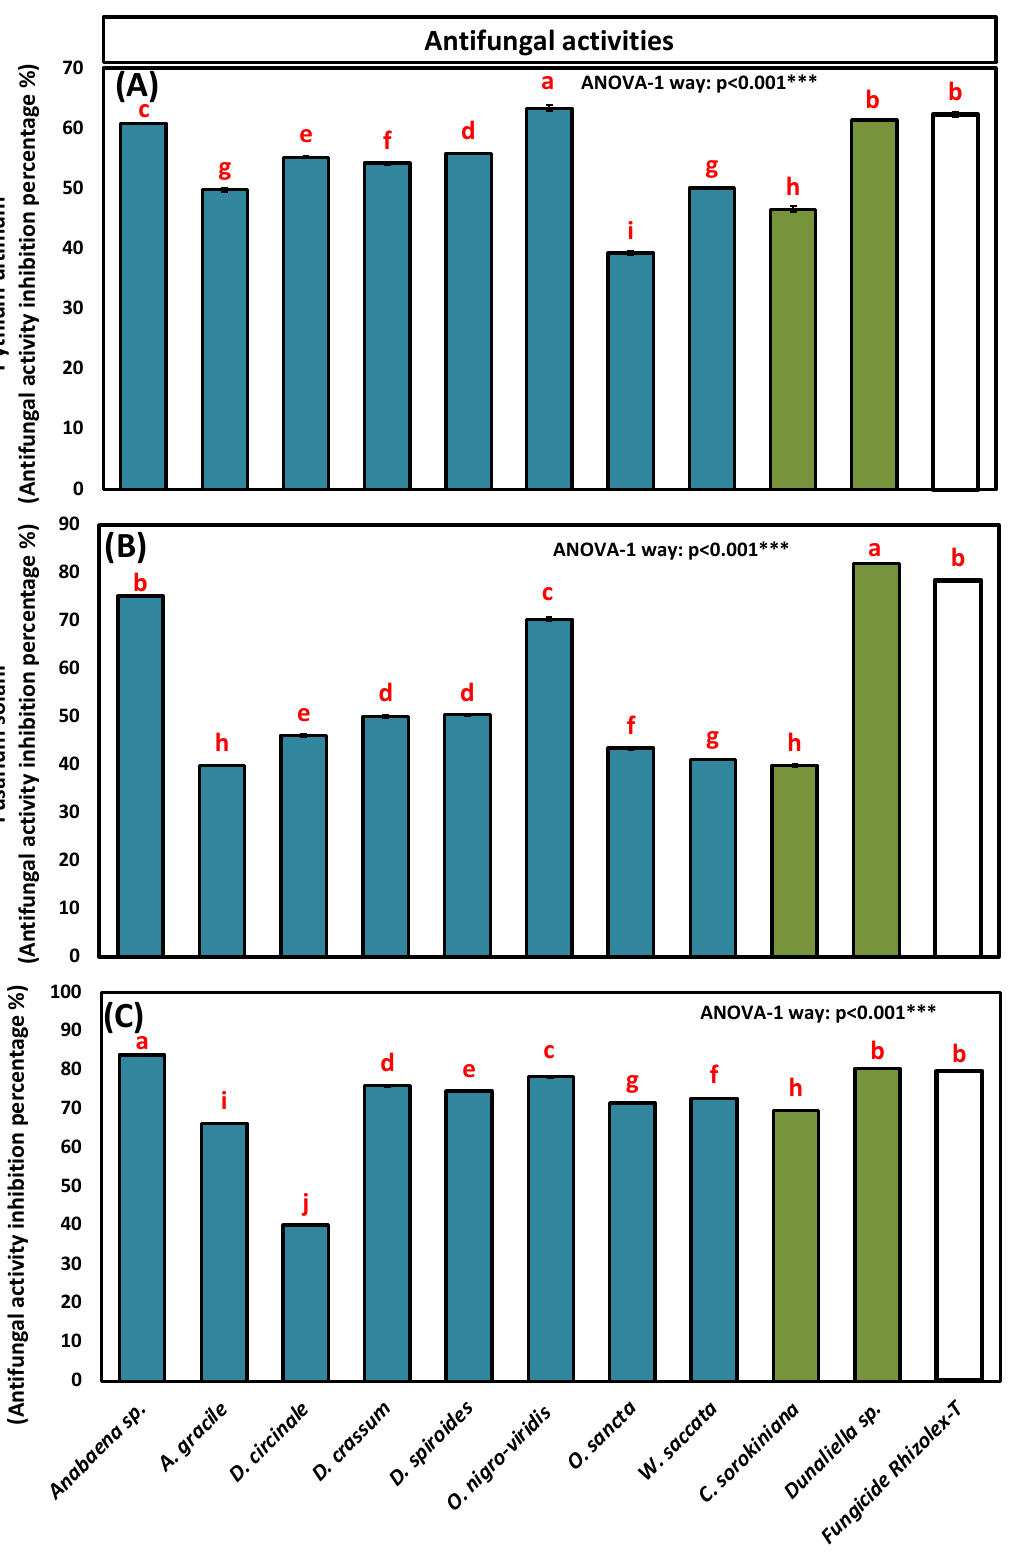
Figure 6. Antifungal activities (%) of the different cyanobacterial and algal strains were studied against Pythium ultimum ( A ), Fusarium solani ( B ), Botryodiplodia theobromae ( C ) fungi. Bars with different superscript letters were significantly different according to DMRT at p < 0.05. *** significant at p < 0.001.